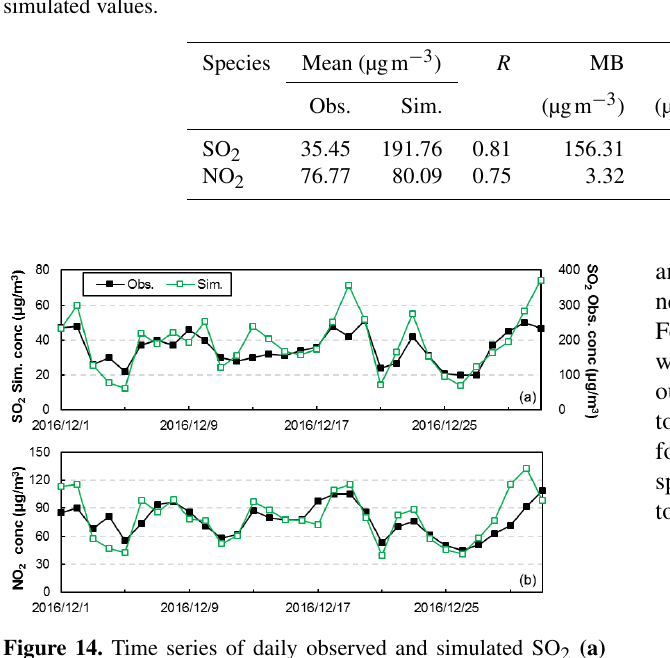
Table 5. Statistical verification parameters of SO 2 and NO 2 during December 2016 in Xi’an. “Obs.” denotes observations, and “Sim.” denotes simulated values.